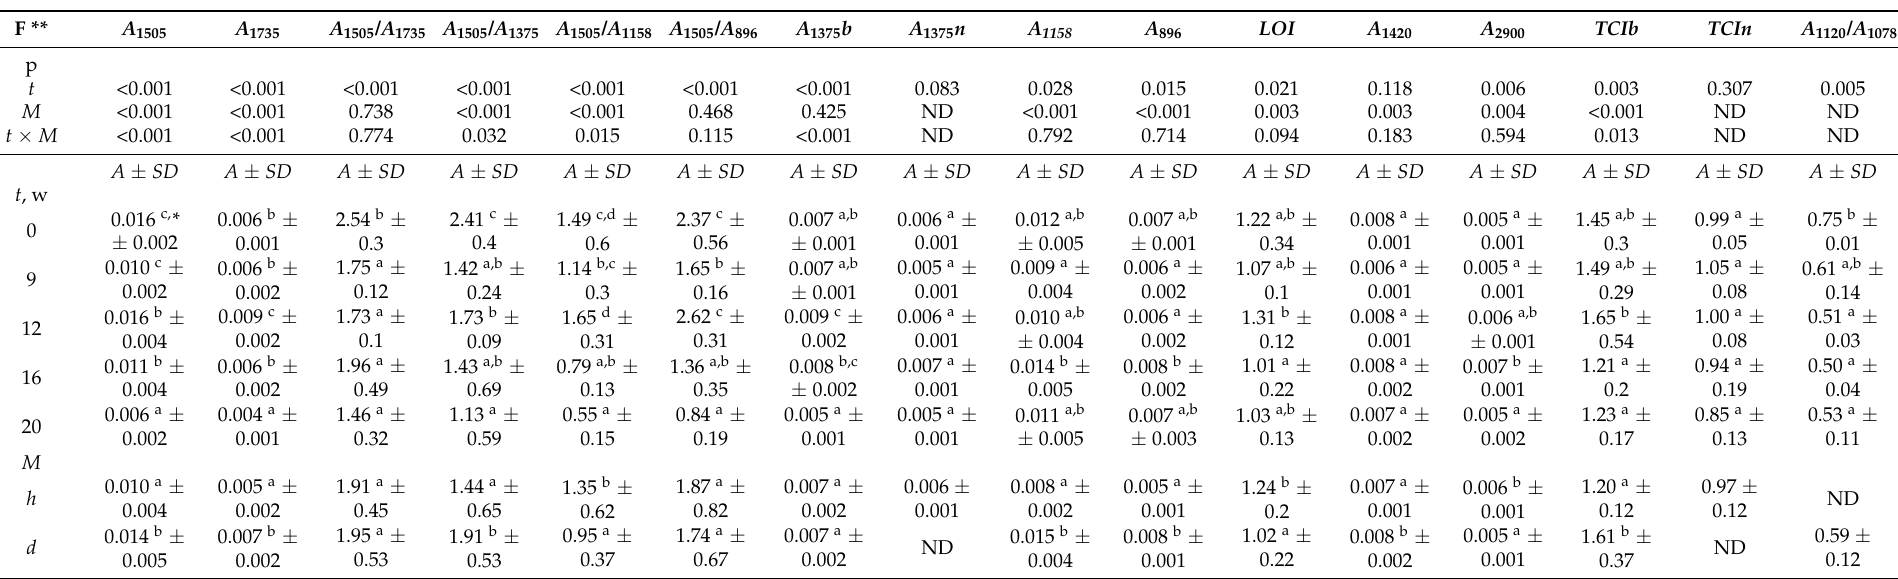
Table 2. Results of the analysis of variance and the mean values and standard deviations (SDs) of indexes of particleboard pretreatment with P. ostreatus